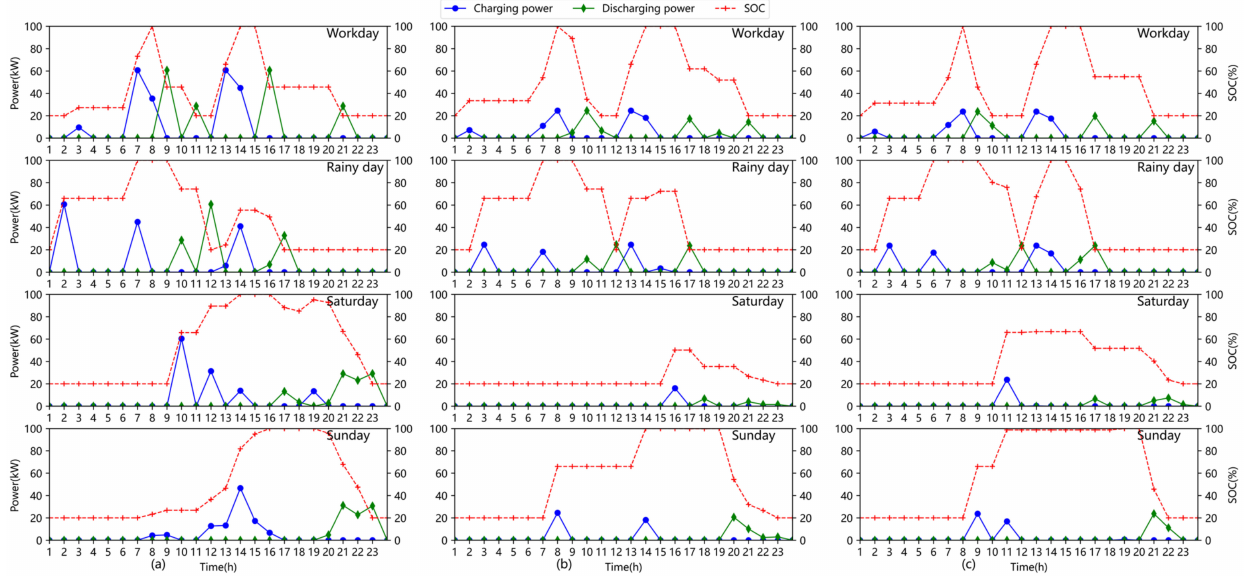
Figure 7. Charging and discharging curves of each ESS under different typical days. ( a ) ESS characteristic below transformer1; ( b ) ESS characteristic below transformer2; ( c ) ESS characteristic below